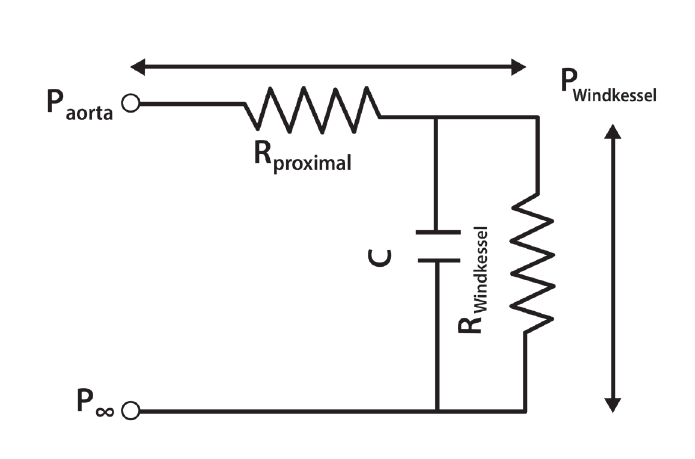
Figure 2. An electrical analogue of the 3-element Windkessel (reservoir). The pressure difference across the whole circuit is equal to the difference between P to characteristic impedance. P across it. C is the compliance and R Windkessel is equal to ( P